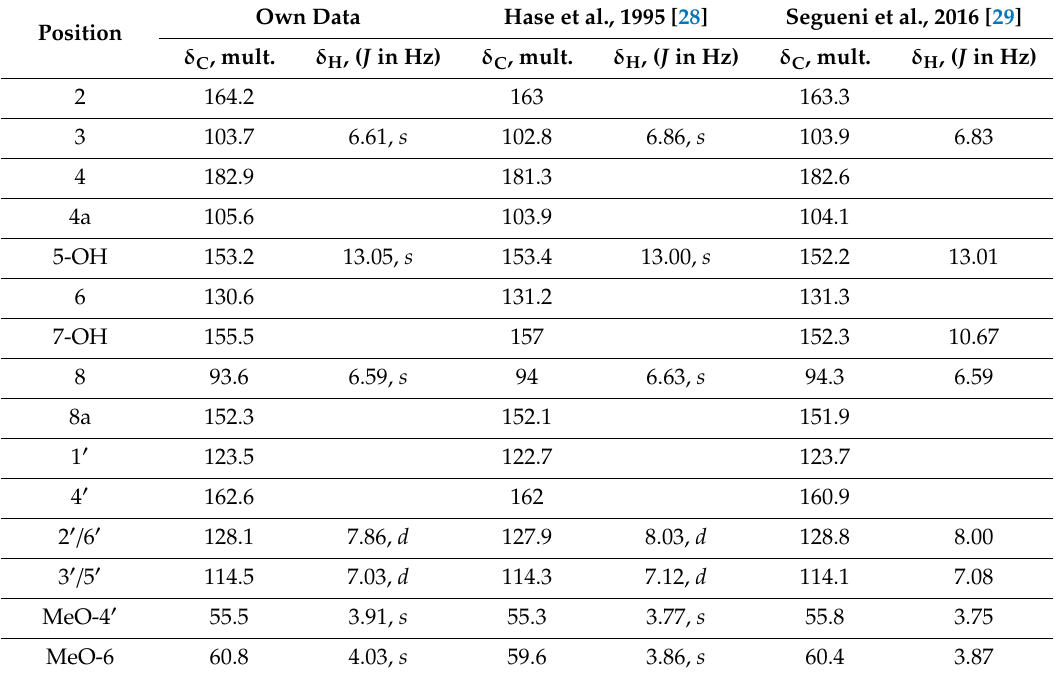
Table 1. 1 H- and 13 C-NMR data of pectolinarigenin (600 MHz for 1 H-NMR and 125 MHz for 13 C-NMR, CDCl3). The data collected from published papers were used to confirm that the structure of the flavonoid